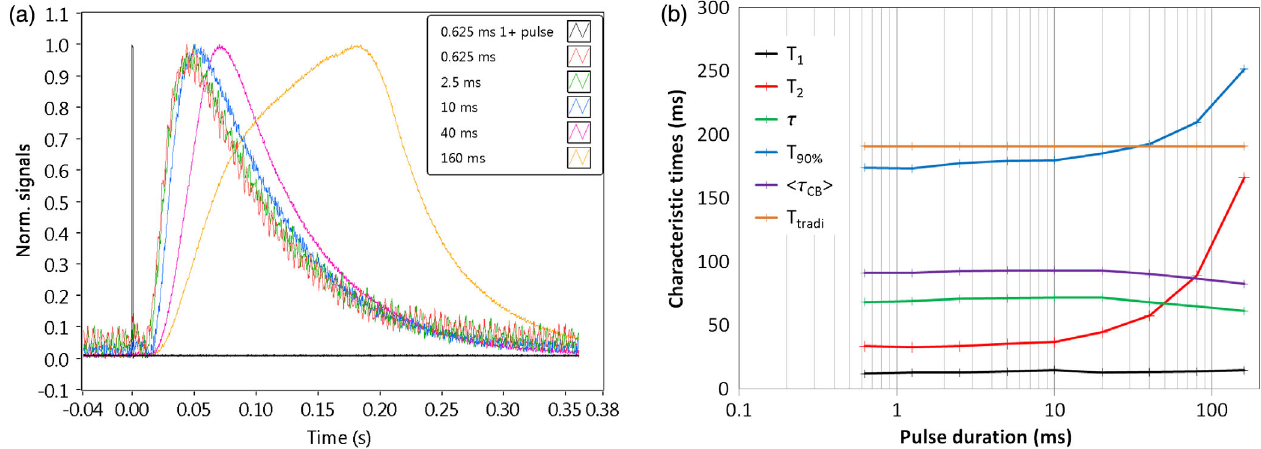
FIG. 5. (a) 0.625 ms pulse command and normalized Rb 19 þ response to 0.625, 2.5, 10, 40, and 160 ms 1 þ pulses. (b) Characteristic times as a function of the 1 þ pulse duration. Characteristic time parameters uncertainty is evaluated at (cid:2) 3 %.